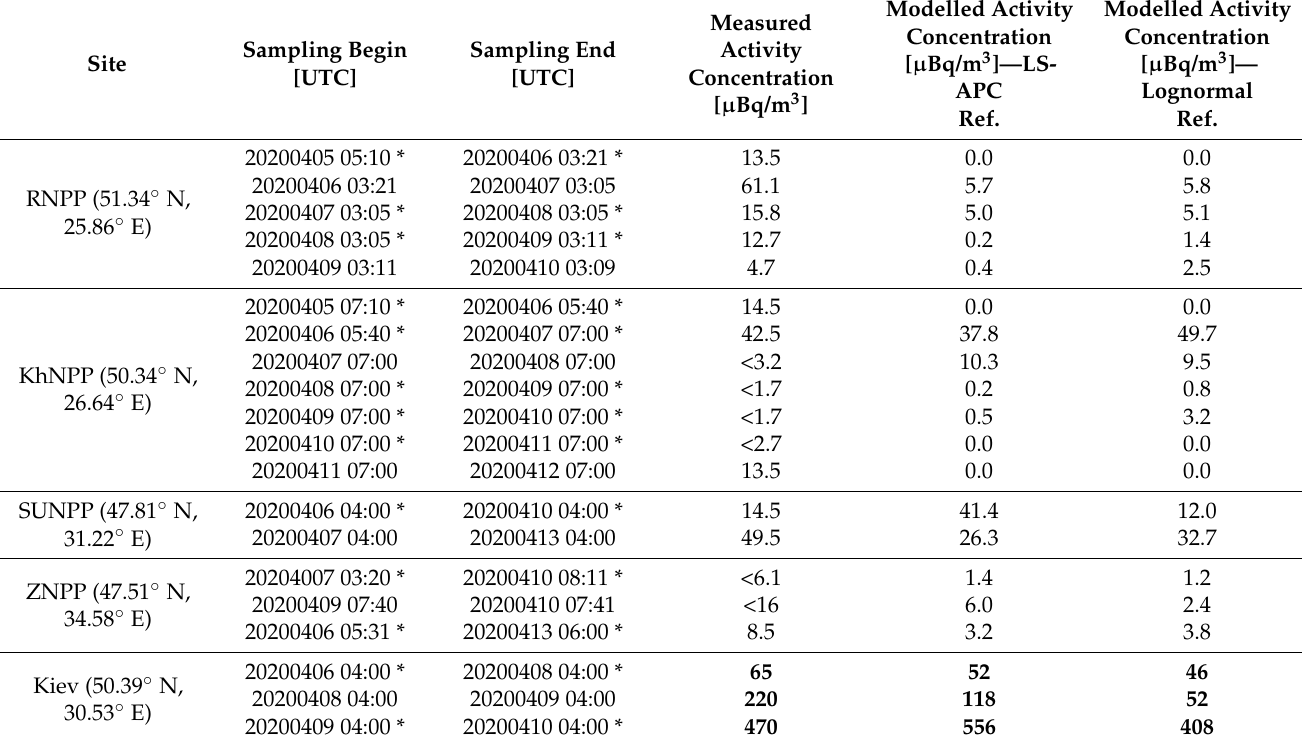
Table 1. List of 20 measured and modelled samples considered in the study. Sub-set of 13 samples is marked with asterisks. Largest (Kiev) measurements are marked in